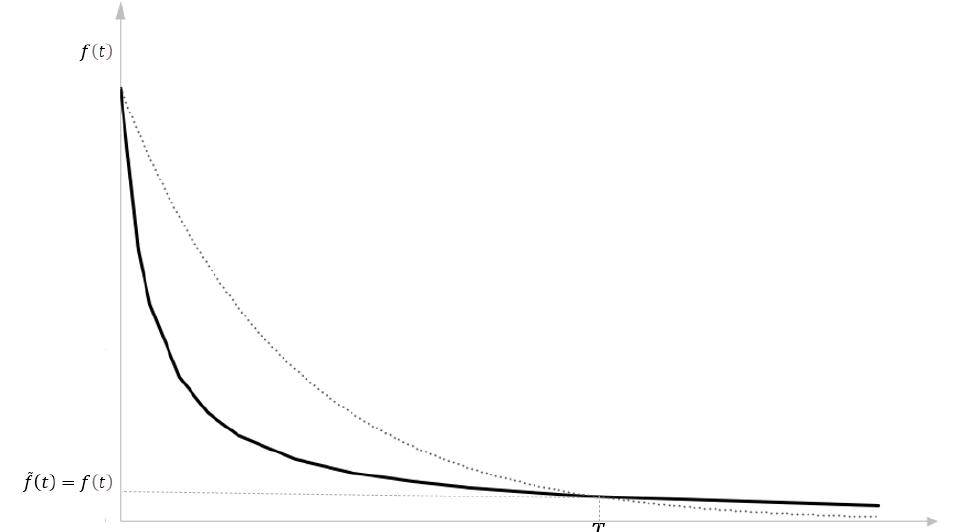
Figure 2: Relationship between a hyperbolic discount function (in black) and an exponential discount function (in